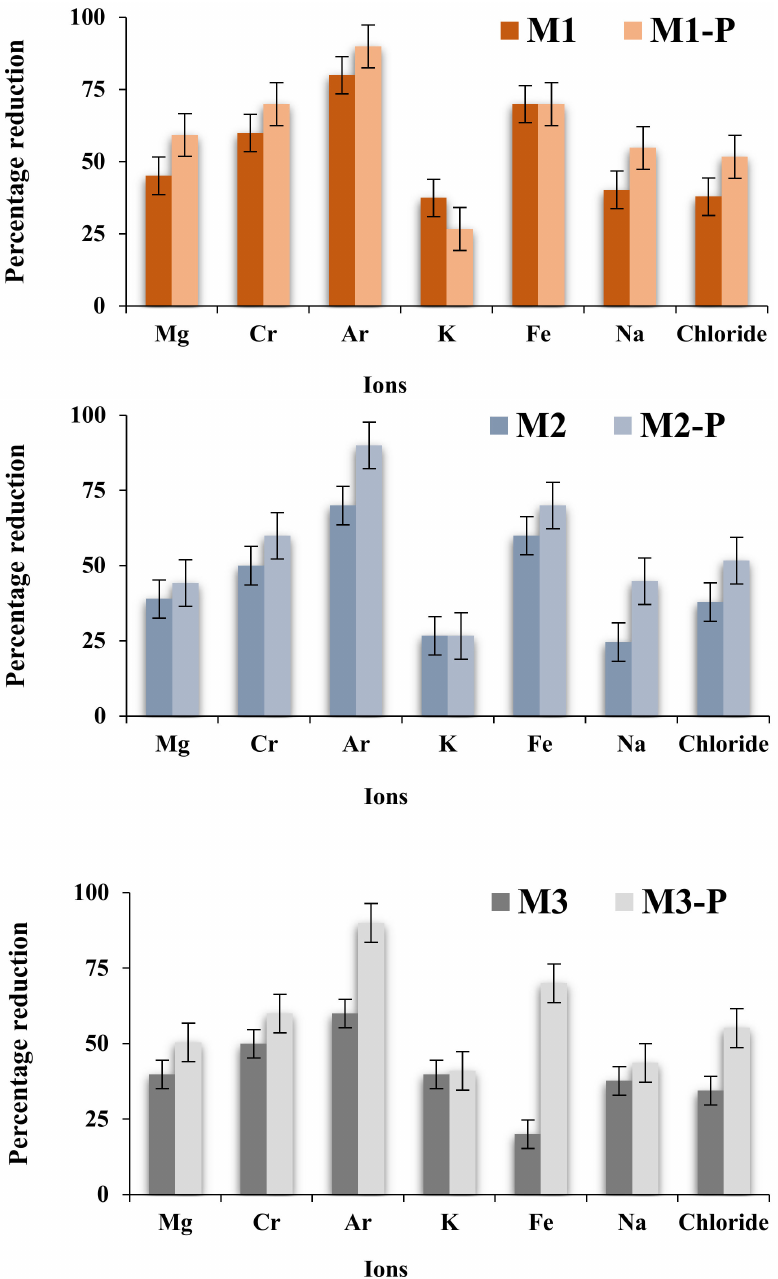
Figure 10. The weight percentage of metal ion rejection after the filtration of lake water through all fabricated and post-treated membranes (SD ≤